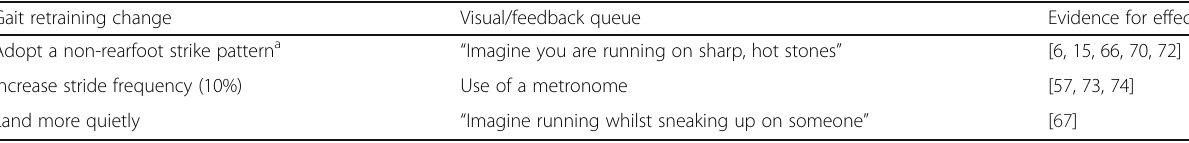
Table 5 Simple gait retraining queues suggested for a minimal footwear